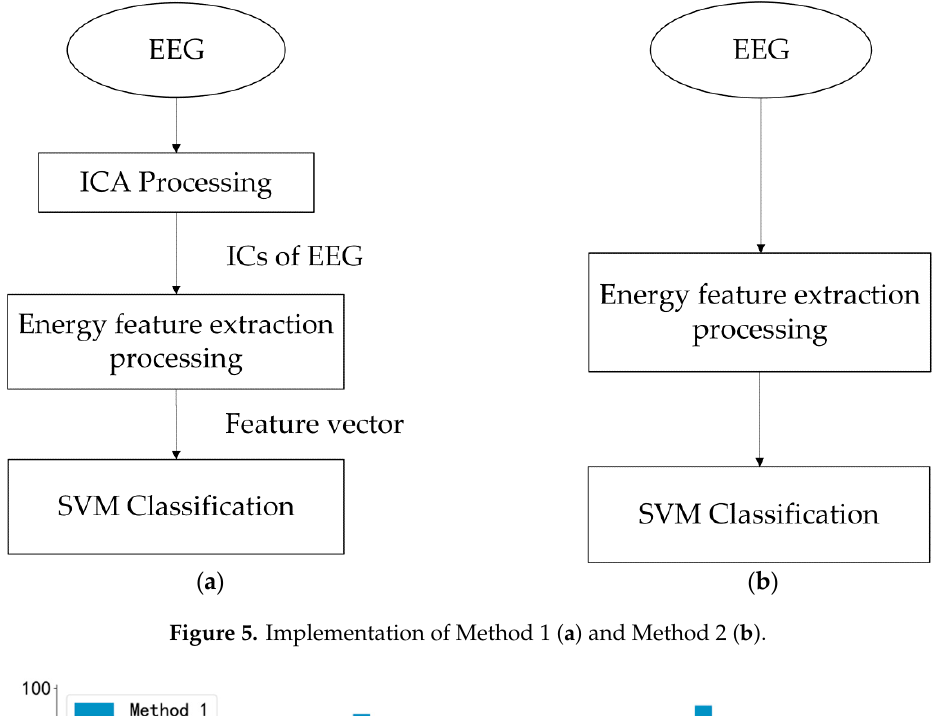
Figure 6. Classification accuracy comparison of Method 1 and Method 2.